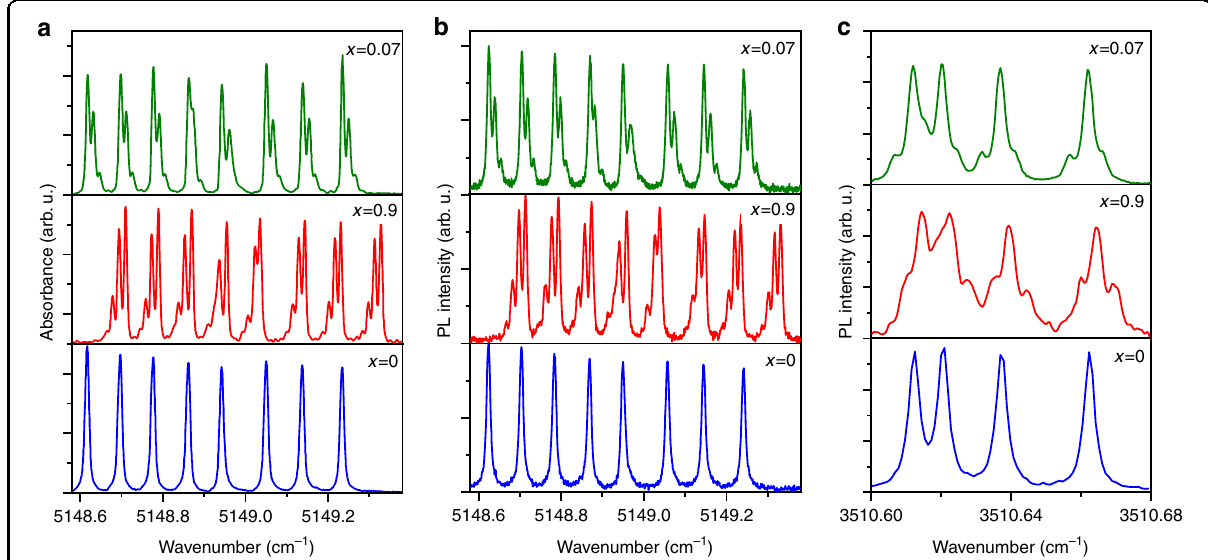
Fig. 3 Isotopic structure of hyper fi ne components in the spectra of crystals with different 6 Li and 7 Li isotope compositions. Isotopic structure in the a absorption and b , c luminescence spectra of 7 Li 1 – x 6 Li x YF 4 :Ho 3 + (0.1 at %) crystals with x = 0.07 (natural abundance of Li isotopes; green traces), x = 0.9 (red traces), and x = 0 (blue traces). a 5 I 8 Г 2 (6.85) → 5 I 7 Г 34 (5155.75), b 5 I 7 Г 34 (5155.75) → 5 I 8 Г 2 (6.85), and c 5 I 6 Г 1 (8673.4) → 5 I 7 Г